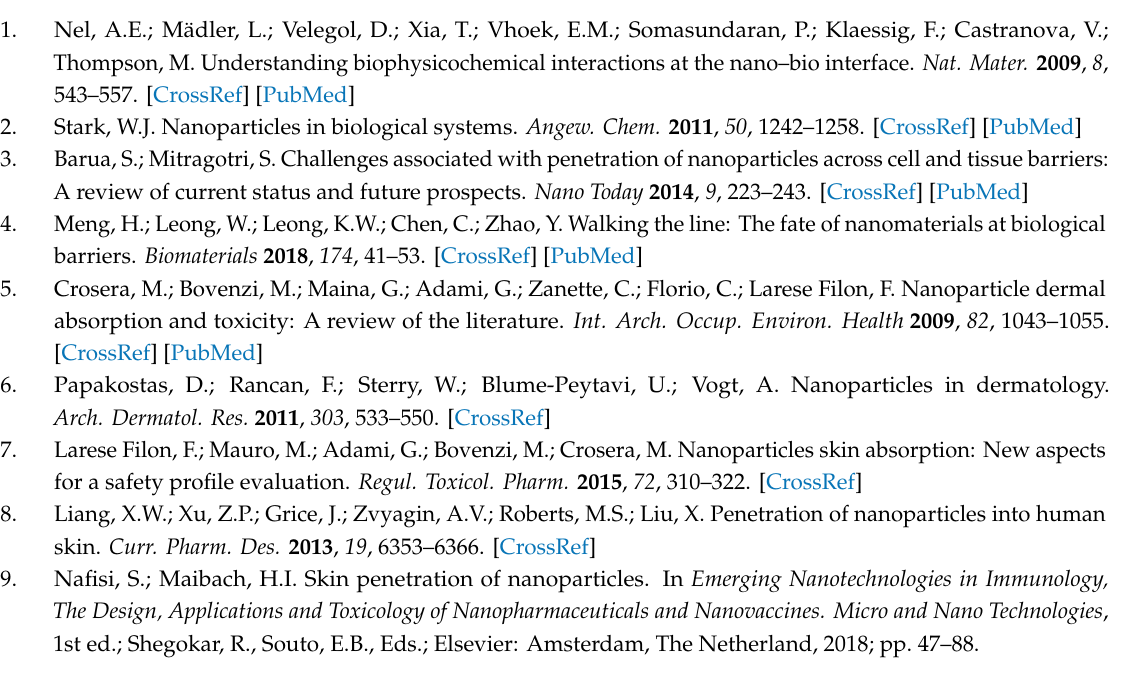
Figure S1: An FLIM of skin autofluorescence. The fluorescence is due to a two-photon excitation with an 800 nm femtosecond laser, and the signal was detected in the spectral range of 450–650 nm. The FLIM reveals the hair follicle structure (with stem cells in the dermal papilla niche (red arrow; (a)), sebaceous glandes (cyan arrows; (b)); as well as the di ff erent skin layers (c). Analogous structures can be distinguished in bright field images (d) and (e). Figure S2: Example of Z-scans of 100 ND-treated skin (images from 1 to 21 were obtained with a step on the z-axis of 0.65 µ m). The signal attributed to NDs is marked by white arrows when seen for the first